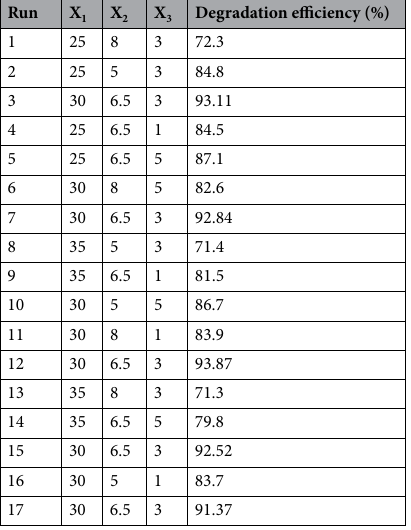
Table 1. Box-Behnken experimental design with three independent variables. X 1 : temperature (°C), X 2 : pH level, X 3 : inoculation amount (× 10 7 cfu/mL).